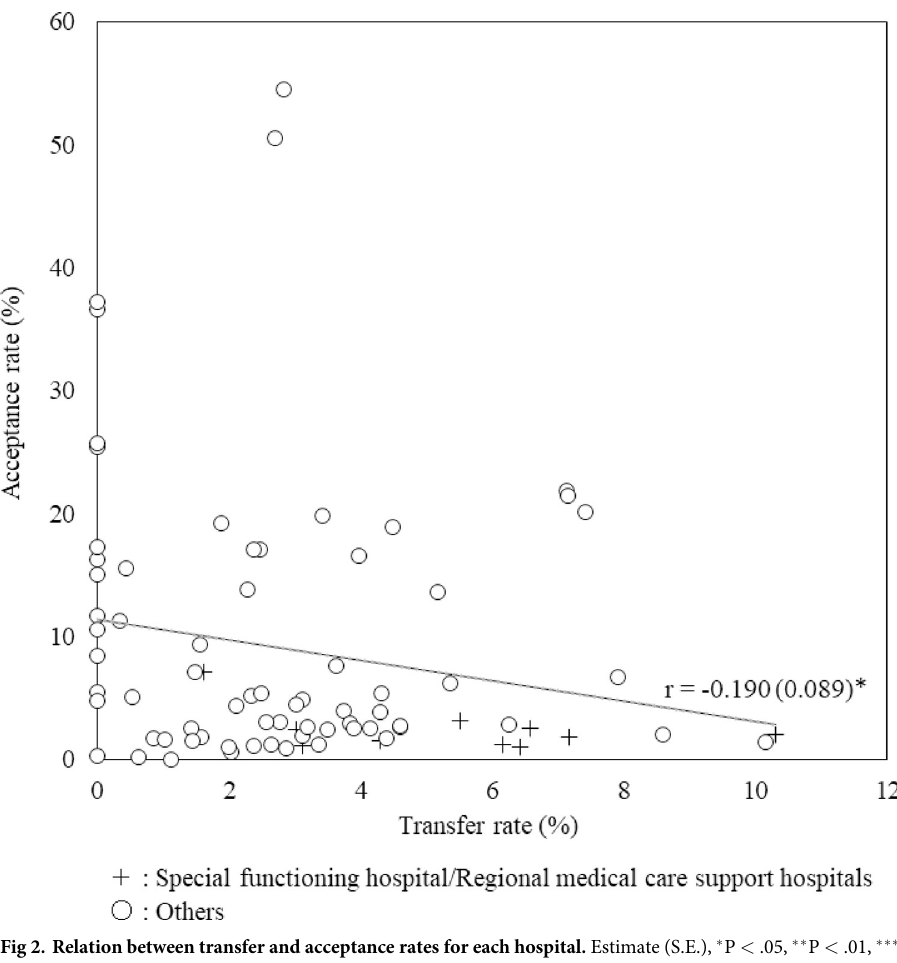
Fig 2. Relation between transfer and acceptance rates for each hospital. Estimate (S.E.), � P < .05, �� P < .01, ��� P <